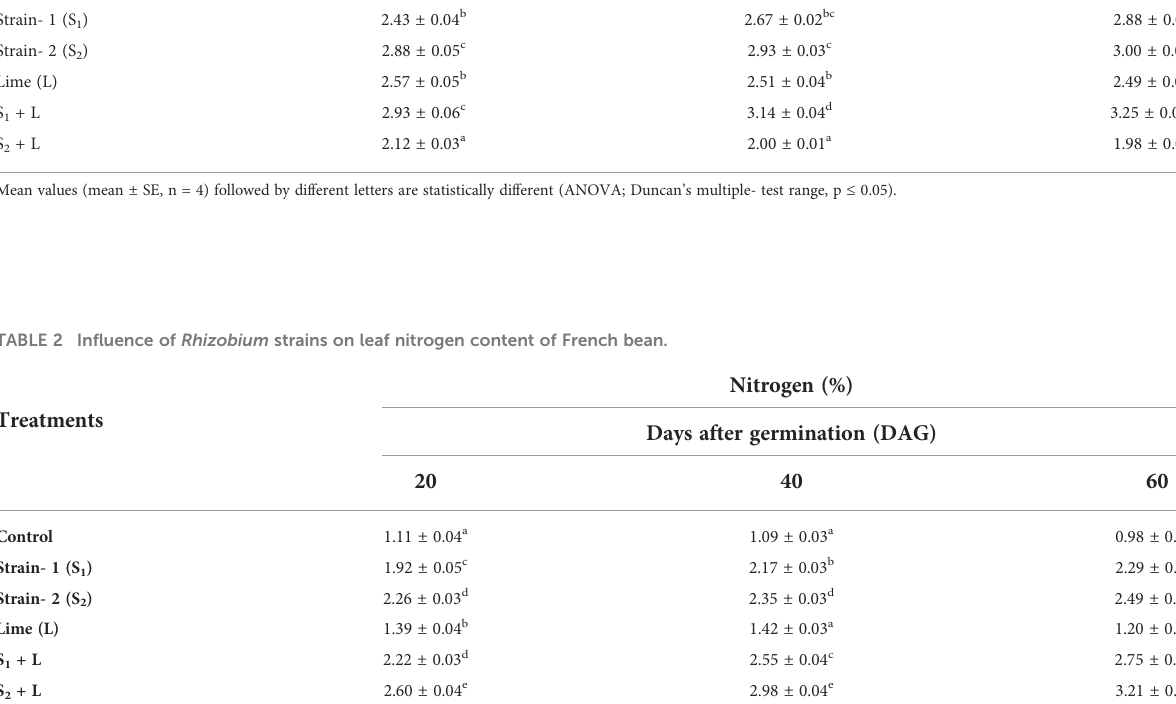
Mean values (mean ± SE, n = 4) followed by different letters are statistically different (ANOVA; Duncan ’ s multiple- test range, p ≤